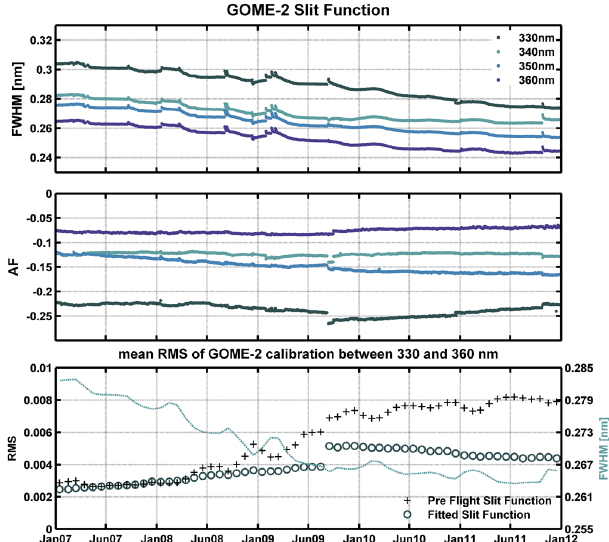
Fig. 6. (a) GOME-2 slit function width (FWHM) and asymmetry factor (AF) fitted during the calibration procedure of the DOAS analysis. (b) Mean residuals of the GOME-2 solar spectrum cali- bration between 330 and 360nm, using the pre-flight slit function or fitting a Gaussian asymmetric slit function. The FWHM of the fitted Gaussian asymmetric slit function is shown as second